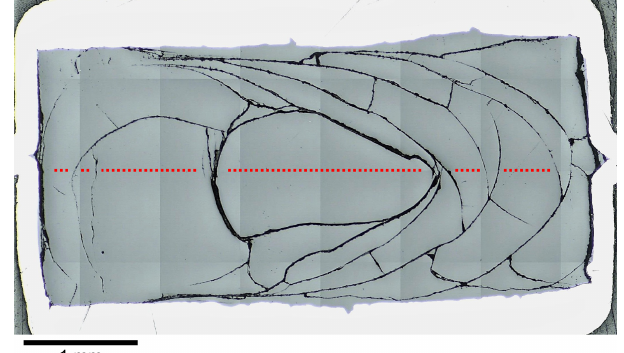
Figure 2. Reflected light mosaic image of the diffusion sample LCT-LK-D-d05; the glass has many quench cracks demonstrating the fragility of the sample; the red dotted line schematically dis- plays the diffusion profile that was measured for this sample (size and distance of measuring points are not true to scale); see Fig. 5a for the corresponding diffusion